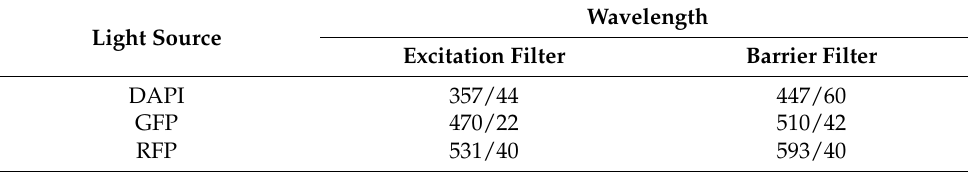
Table 1. Wavelength parameters of the fluorescent light source used to detect the fluorescent